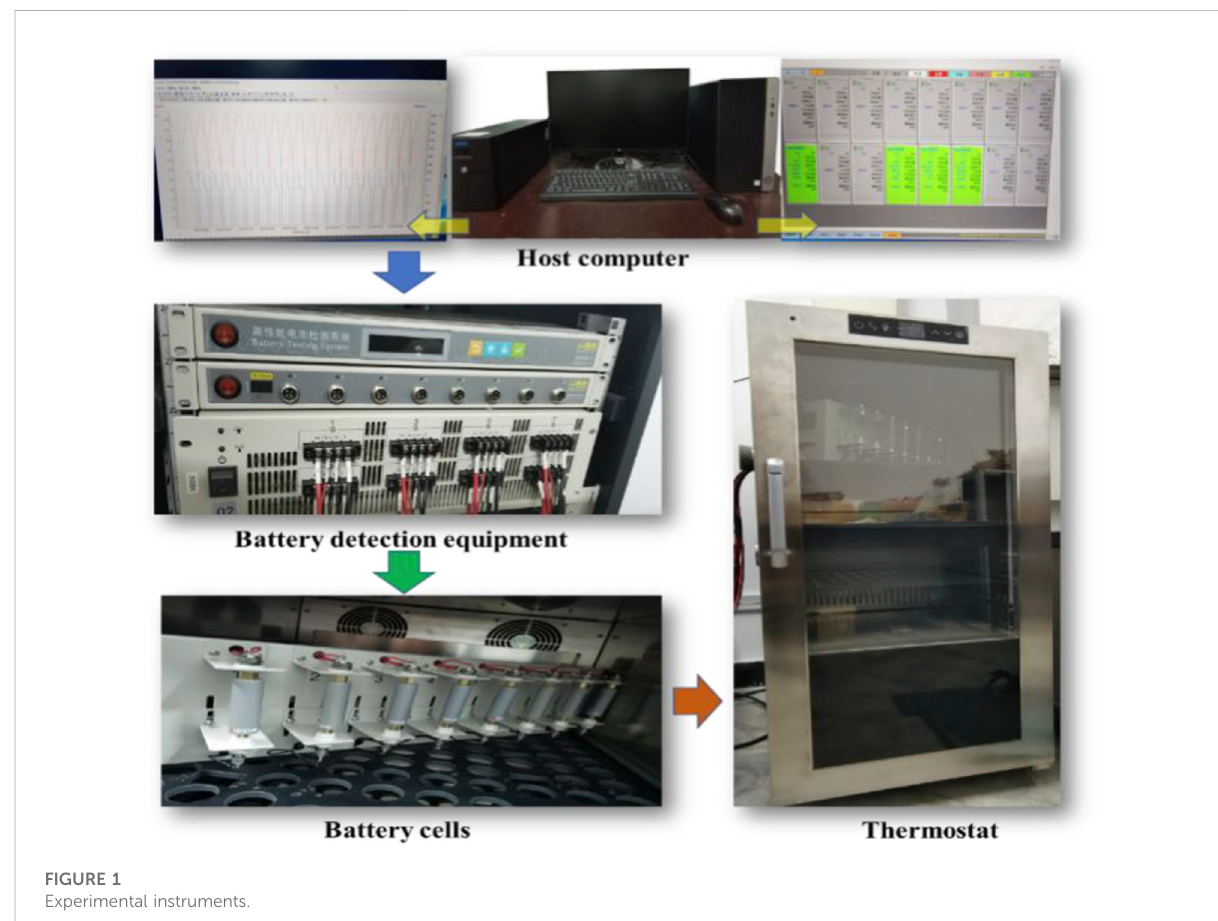
FIGURE 1 Experimental instruments.